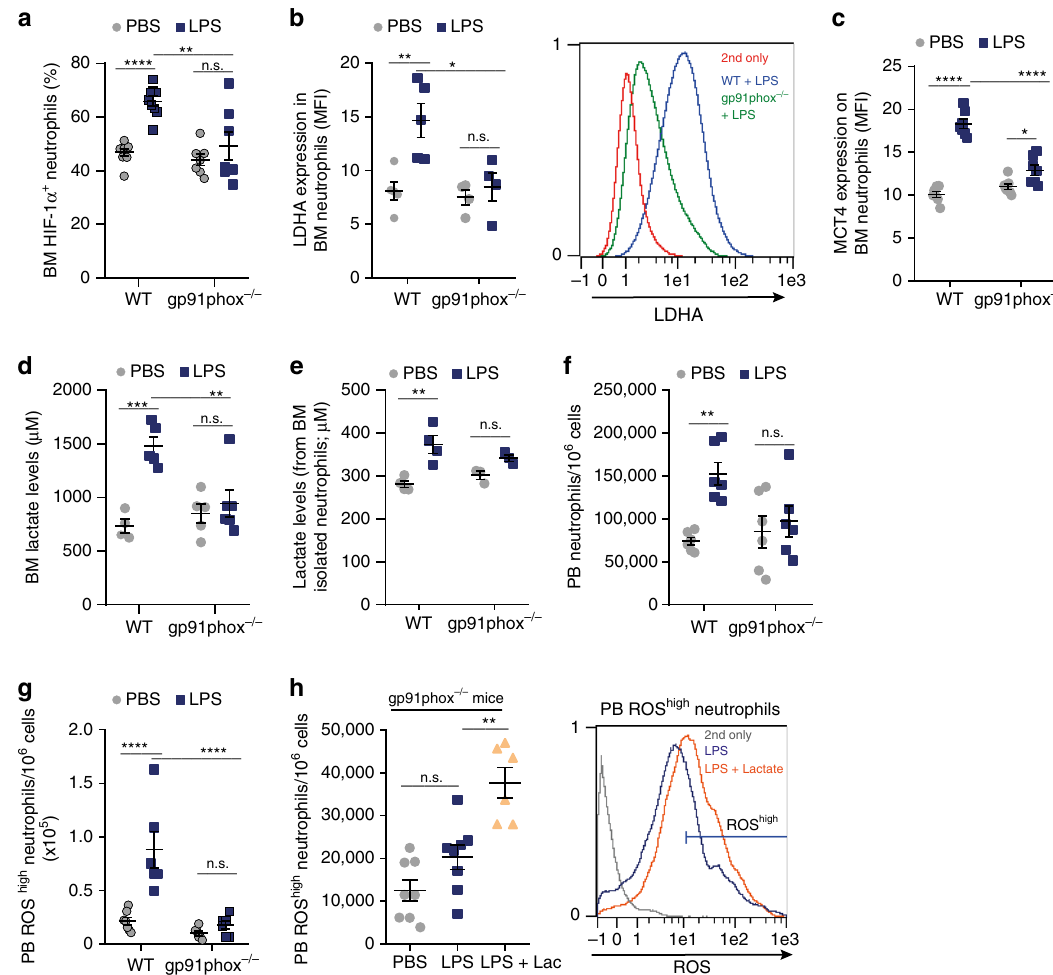
Fig. 3 Lactate production by neutrophils requires NOX/ROS signaling. a Percentage of BM HIF-1 α + neutrophils in WT ( n = 9) and gp91phox − / − ( n = 7) mice treated with either PBS or LPS. **p(WT + LPS vs. gp91phox − / − + LPS) = 0.0012. b Quantitative analysis and representative histogram plot showing LDHA expression in BM neutrophils from WT ( n = 5) and gp91phox − / − ( n = 4) mice. ** p (WT + PBS vs. WT + LPS) = 0.0054; * p (WT + LPS vs. gp91phox − / − + LPS) = 0.0131. c Quantitative analysis of MCT4 expression on BM neutrophils from WT ( n = 7) and gp91phox − / − ( n = 7) mice treated with either PBS or LPS. * p (gp91phox − / − + PBS vs. gp91phox − / − + LPS) = 0.0424. d BM lactate levels in WT ( n = 4, PBS; n = 5, LPS) and gp91phox − / − ( n = 5, PBS; n = 6, LPS) mice treated with LPS. e BM lactate levels released from WT or gp91phox − / − isolated neutrophils treated ex vivo with PBS or LPS (120 ng/ml; n = 4, WT; n = 3, gp91phox − / − ). f , g Frequency of PB neutrophils from WT and gp91phox − / − ( f , n = 6; ** p (WT + PBS vs. WT + LPS) = 0.0058) and ROS high neutrophils ( g , n = 7, WT + PBS; n = 6, WT + LPS; n = 6, gp91phox − / − mice) following LPS injection. h Quantitative analysis and representative histogram plot of PB ROS high neutrophils of gp91phox − / − mice treated with PBS, LPS, or LPS together with 50.5 mg lactate ( n = 8, PBS or LPS; n = 6, LPS + lactate). ** p (LPS vs. LPS + lactate) = 0.0018. Data are represented as mean ± SEM from 3 to 4 independent experiments. * p < 0.05; ** p < 0.01; *** p < 0.001; **** p < 0.0001, one-way ANOVA with Tukey ’ s post hoc test ( h ) or two-way ANOVA with Tukey ’ s post hoc test ( a – g ). See also Supplementary Fig.